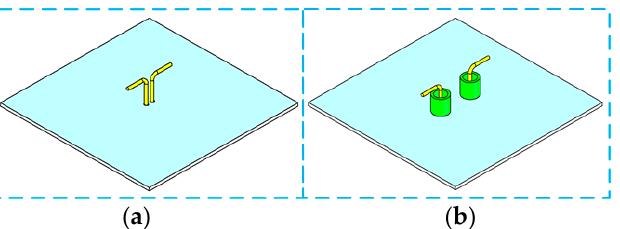
Figure 2. The proposed antenna’s wideband design procedure. ( a ) dipole without sleeves; ( b ) dipole with sleeves.